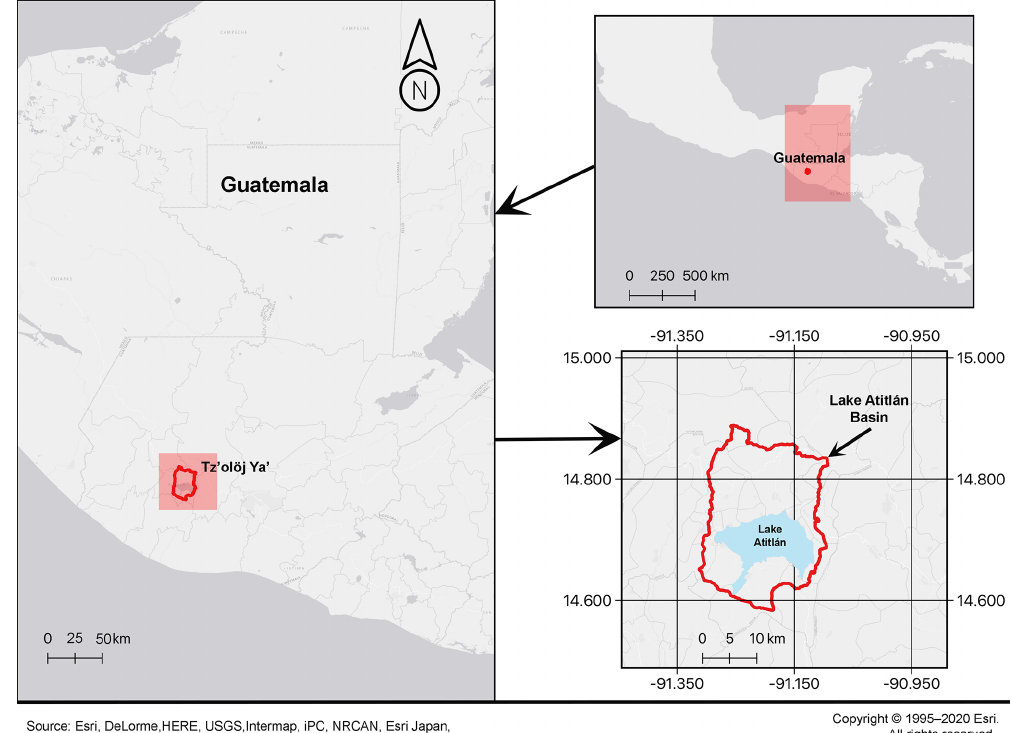
Figure 2. Location of the study area in Guatemala. Created in QGIS software using Esri